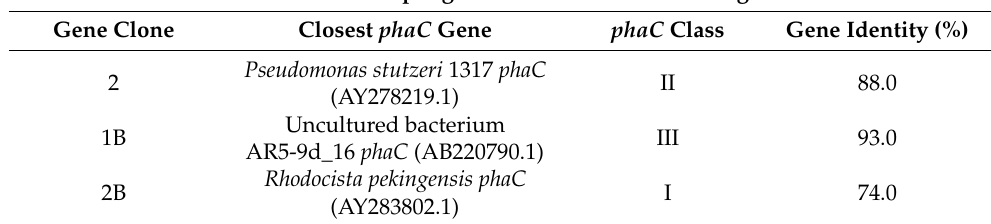
Table 4. PHA synthase ( phaC ) genes identified from strain isolates from marine sponge- associated metagenome. Cloned Genes from Sponge-Associated Bacterial Metagenome Gene Clone Closest phaC